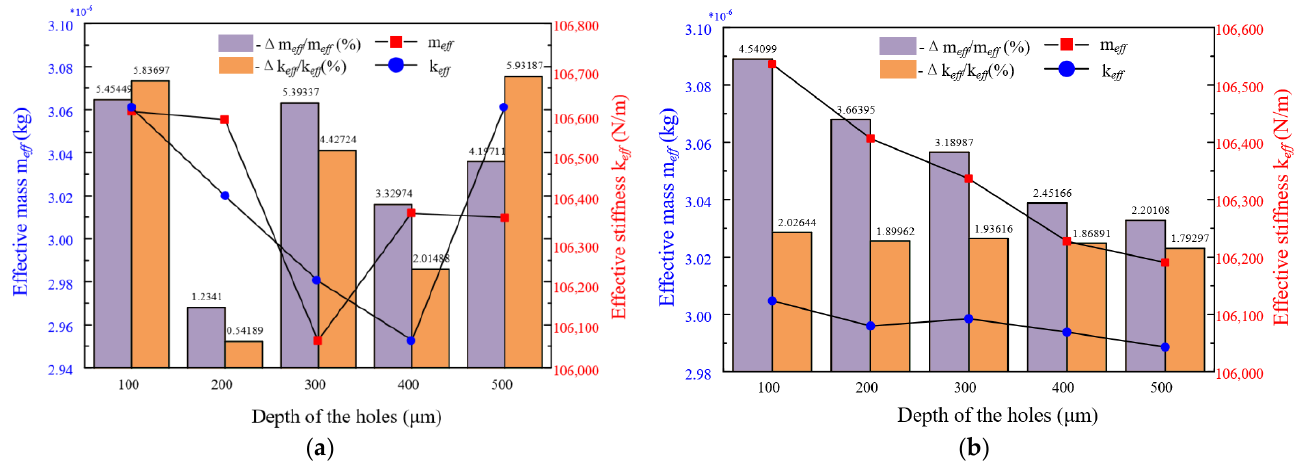
Figure 5. Compare the influence of punching holes at different places for the effective mass and effective stiffness. ( a ) Punch holes on the ring; ( b ) Punch holes on the mass blocks.